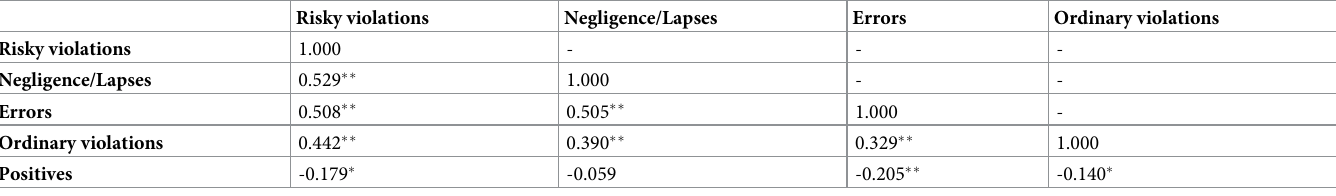
Table 3. Correlation matrix between factors of the questionnaire and total